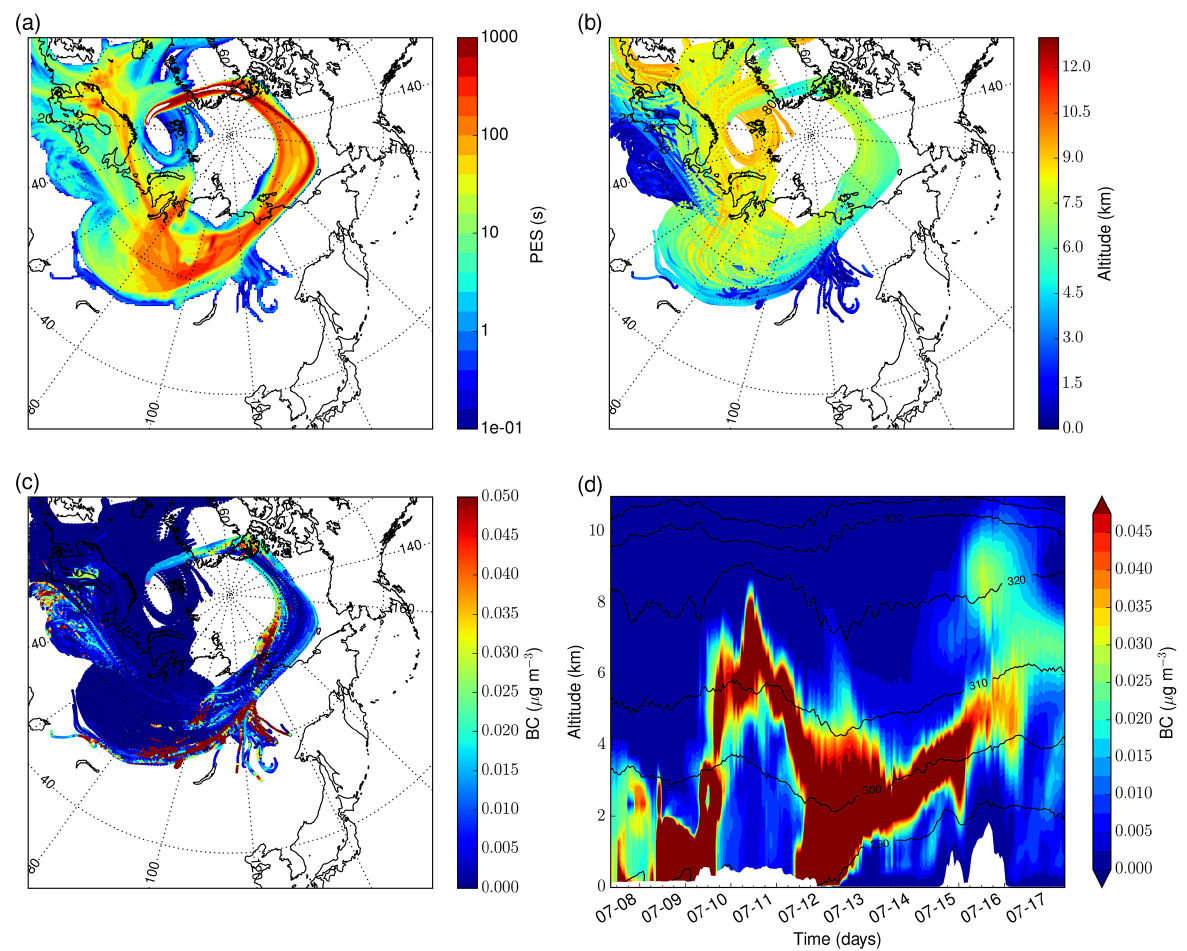
Figure 10. FLEXPART-WRF backward simulation from the biomass burning plume observed by the Falcon aircraft at 73.1 ◦ N, 18.2 ◦ E and 6 . 5km between 08:37 and 08:47UTC. (a) Column-integrated PES, (b) altitude and (c) BC mass concentration interpolated along the 10000 trajectories for 10 days prior to the release. In panel (d) , the vertical cross section of BC interpolated along the plume centroid location is shown, together with the dry isentropes (black lines) between 290 and